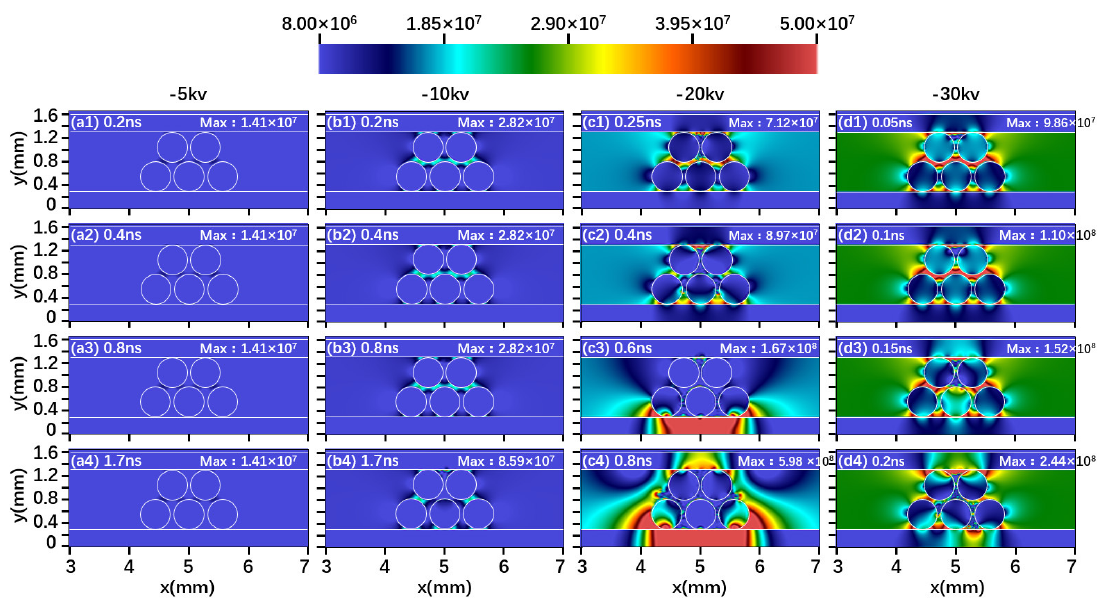
Figure 6. Electric field amplitude | E | (V/m) for the same conditions as in Figure 1. The maximum values are noted in each panel. They occur at the contact points between the beads, and are larger than the color scale, but the color scale is chosen in such a way to better illustrate the general